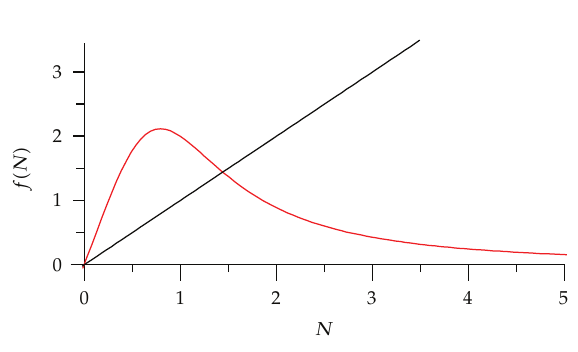
Figure 1: Population model